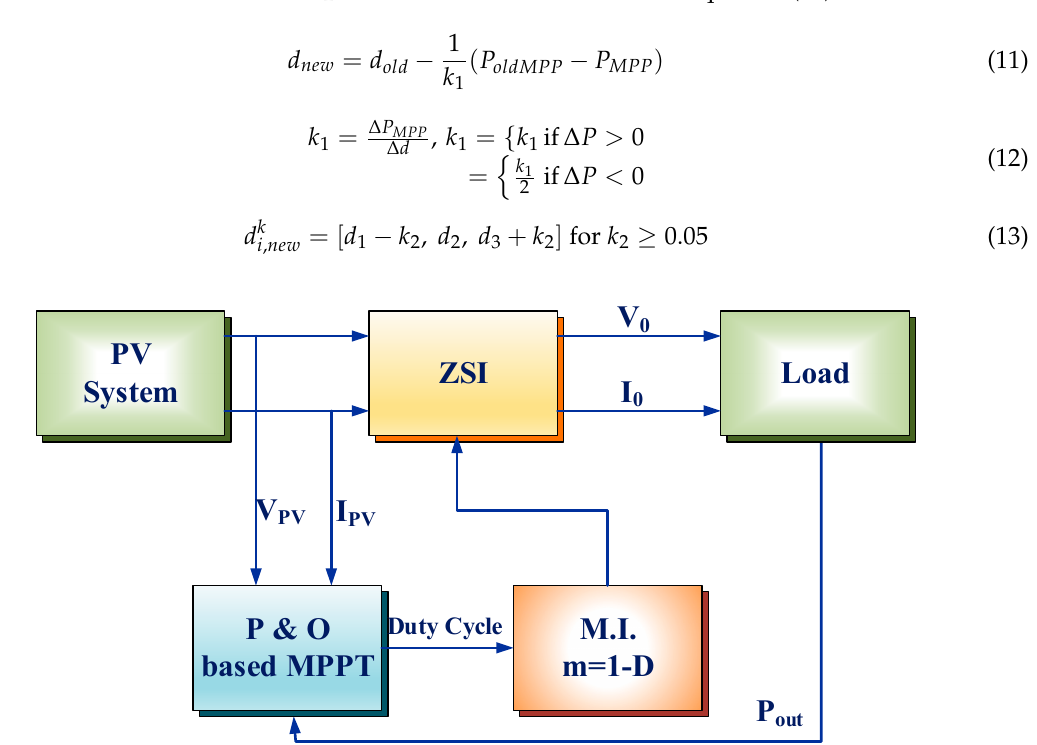
Figure 9. Closed loop model of proposed PSO method.